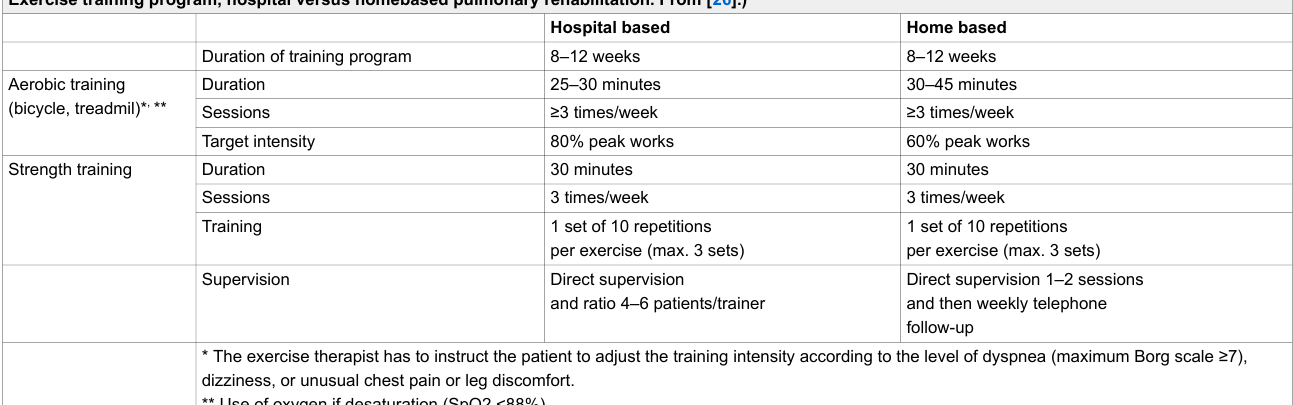
Table 2 Exercise training program, hospital versus homebased pulmonary rehabilitation. From